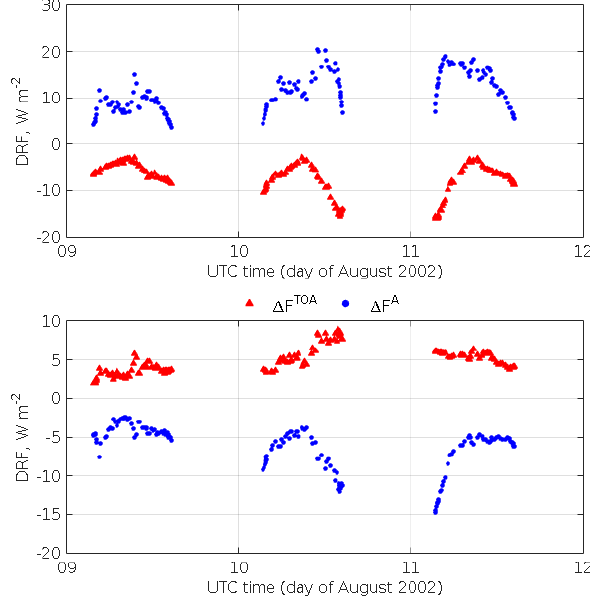
Figure 4. SW (top panel) and LW (bottom panel) computed surface upwelling fluxes with approximated surface temperature (P, blue) and prescribed from ERA-Interim (PE, black) and in situ measure- ments (Obs, red) at Solar Village. Aeronet SDA column AOD at 500nm (top panel, green) is plotted against the right vertical axis.